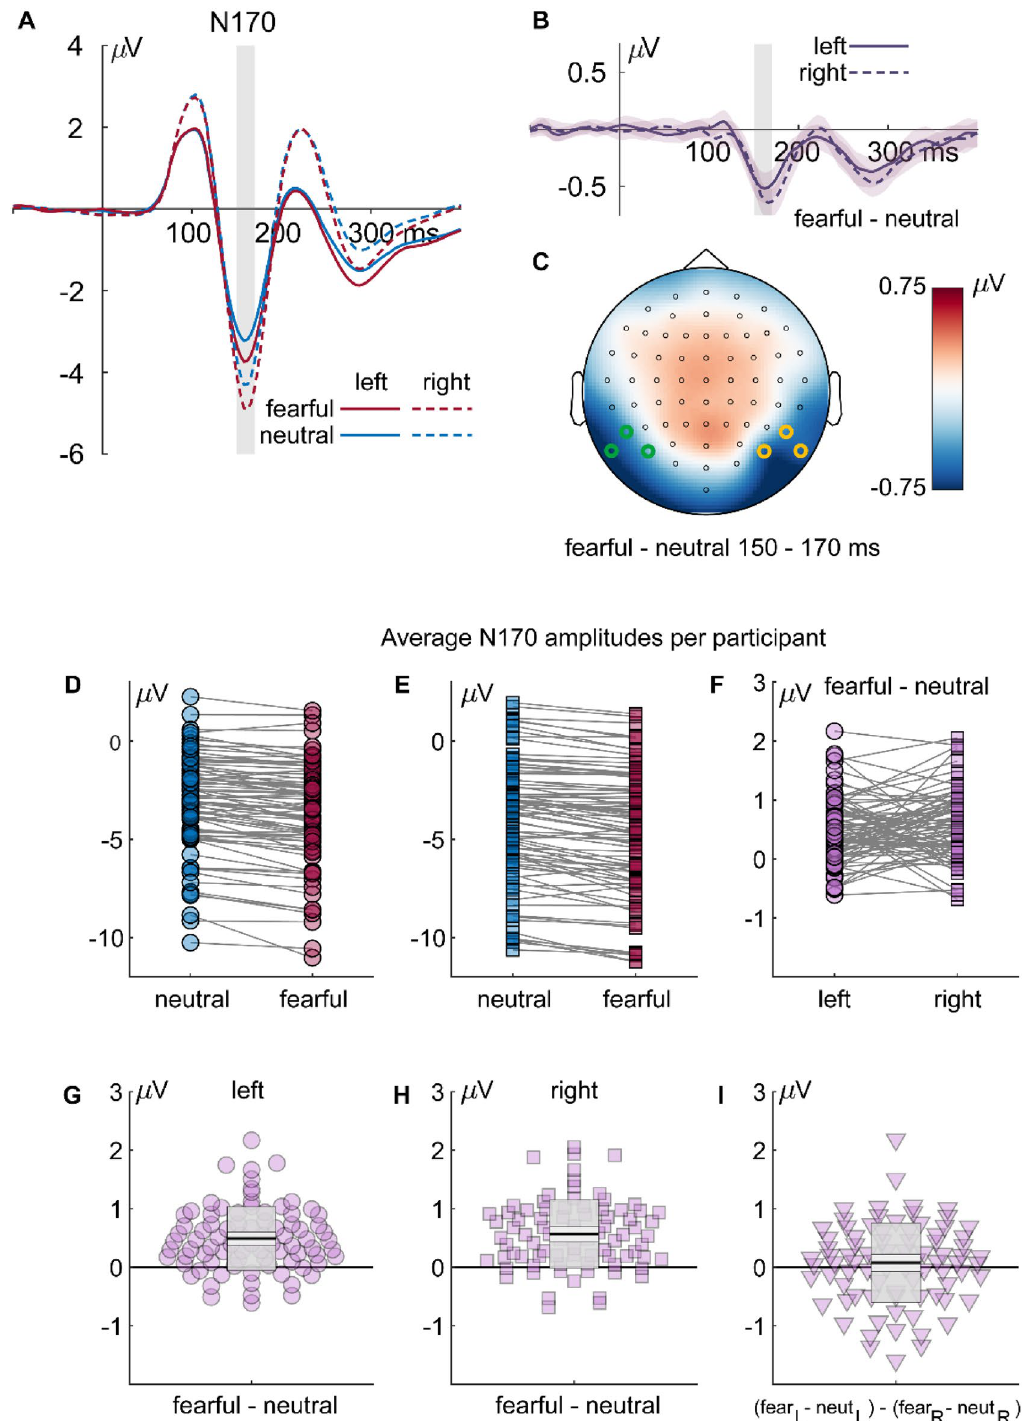
Figure 5. Results for the N170 component: ( A ) ERP waveforms for all fearful (red) and neutral (blue) expressions, separate for left (solid lines; P7, P9, and PO7) and right (dashed lines; P8, P10, and PO8) electrodes. ( B ) Differential ERPs (fearful–neutral; purple), separate for left (solid lines) and right (dashed lines) electrodes. The gray rectangles mark the interval of interest used for calculating average amplitudes and for the topography. Shaded areas around the differential ERPs depict the 95% bootstrap confidence intervals around the mean difference. ( C ) Topography of the differences in the highlighted interval of interest. ( D – F ) individual average N170 amplitudes or amplitude differences, respectively. ( G , H ) Individual differences between fearful and neutral faces and ( I ) individual left/right differences of fearful/neutral differences. The dots are horizontally displaced proportional to the local density to reduce cluttering. The superimposed gray boxes illustrate ± 1 standard deviation (SD; dark gray) and ± 1 standard error of measurement (SEM; light gray) around the mean (black